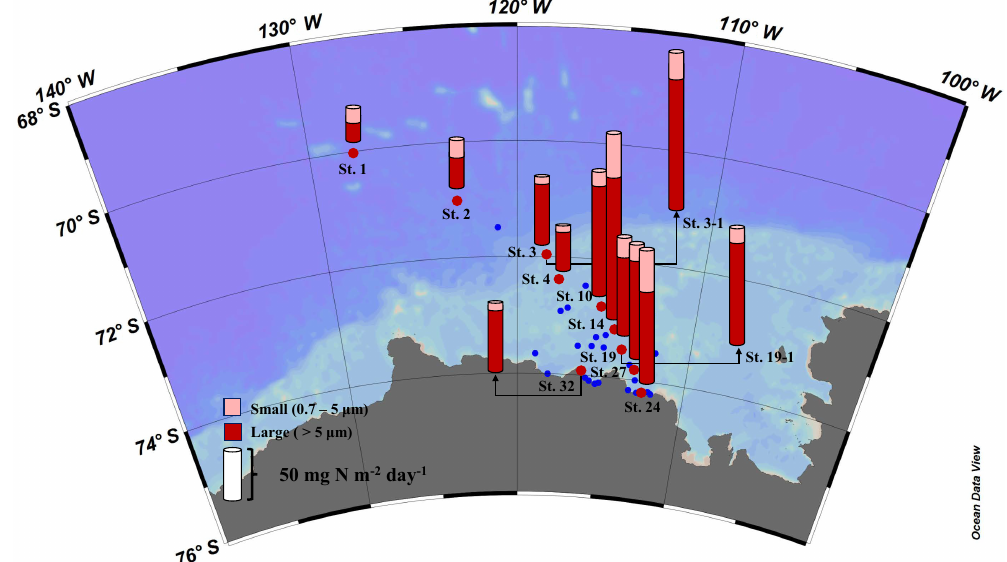
Figure 5. Water-column-integrated daily nitrate uptake rates (mgNm − 2 d − 1 ) of small (0.7–5µm) and large (>5µm) phytoplankton.